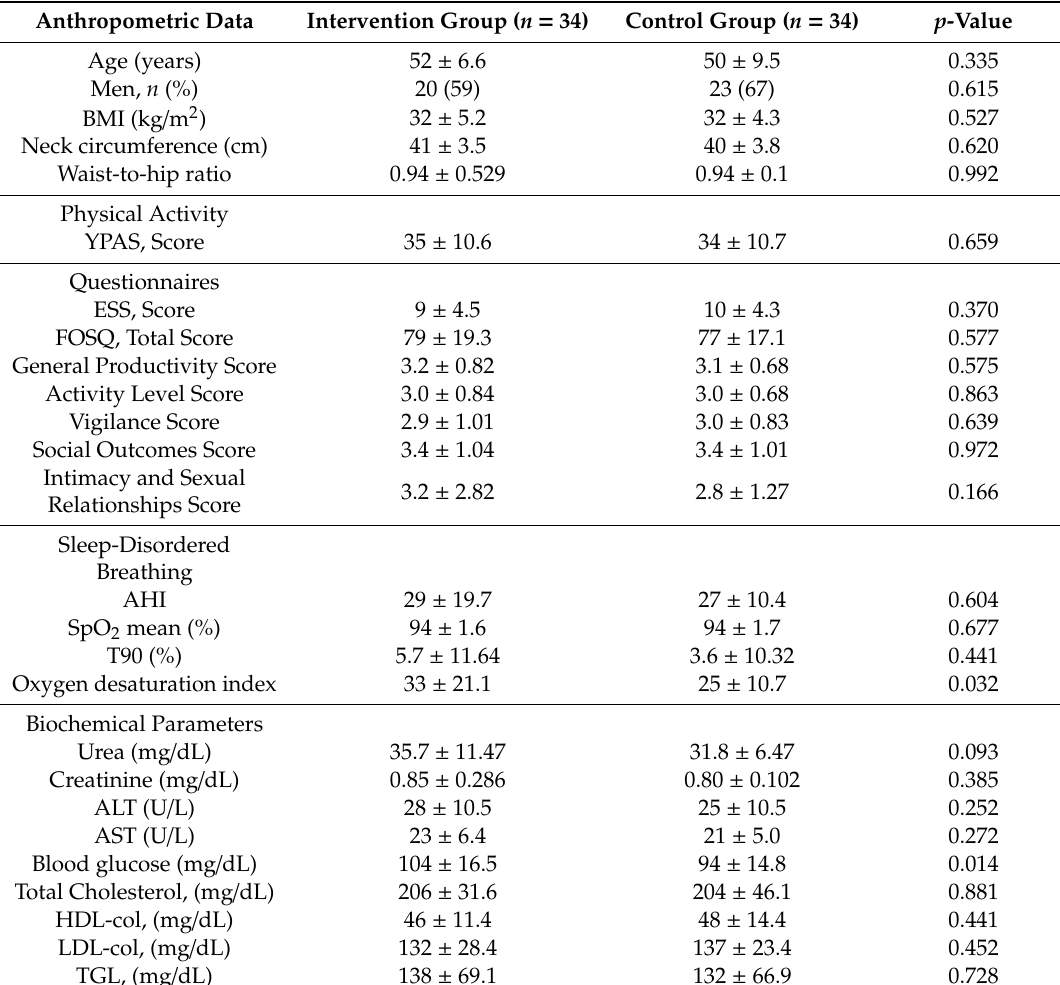
Table 1. Baseline characteristics of the subjects included in the